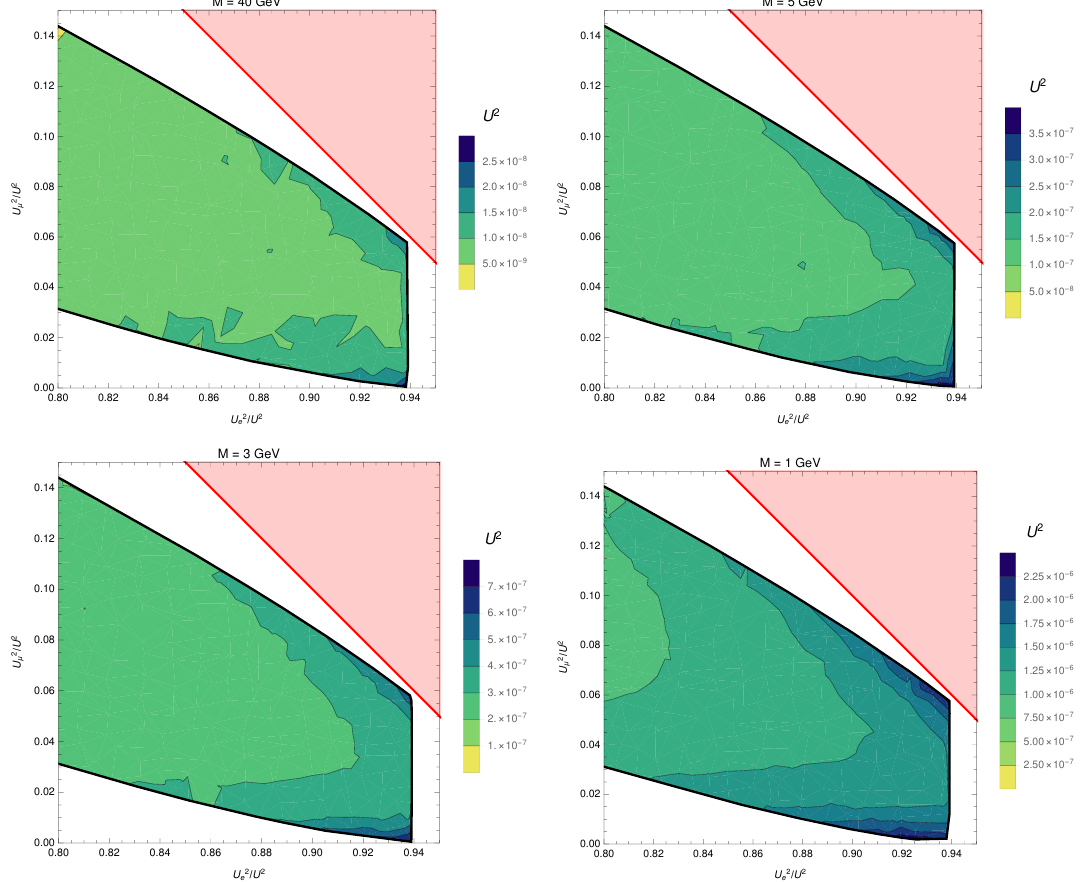
Figure 10 . Magni(cid:12)ed view of (cid:12)gure 9 to show the corner of parameter space that yields maximal mixings U 2 separately for the Majorana masses M i : 1 GeV (top left), 3 GeV (top right), 5 GeV (bottom left) and 40 GeV (bottom